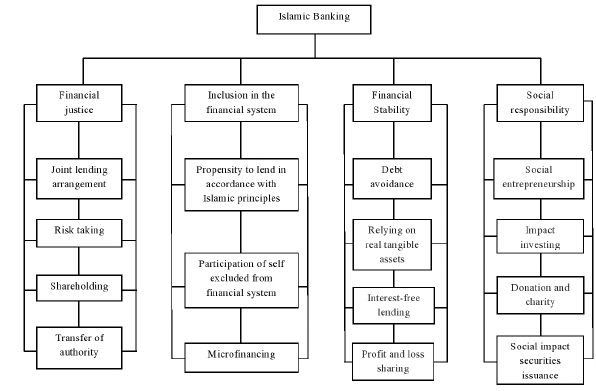
Figure 5. Model of fuzzy sets in the analytical hierarchy of Islamic banking by criteria and sub-criteria. Source: